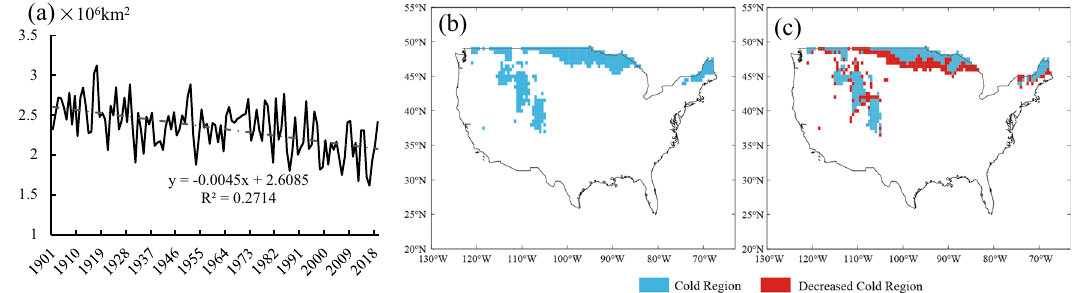
Figure 8. Area and spatial variations of the cold regions in the United States from 1901 to 2019. ( a ) The time change from 1901 to 2019; ( b ) Spatial distribution for Period 1; ( c ) the difference between Period 4 and Period 1.